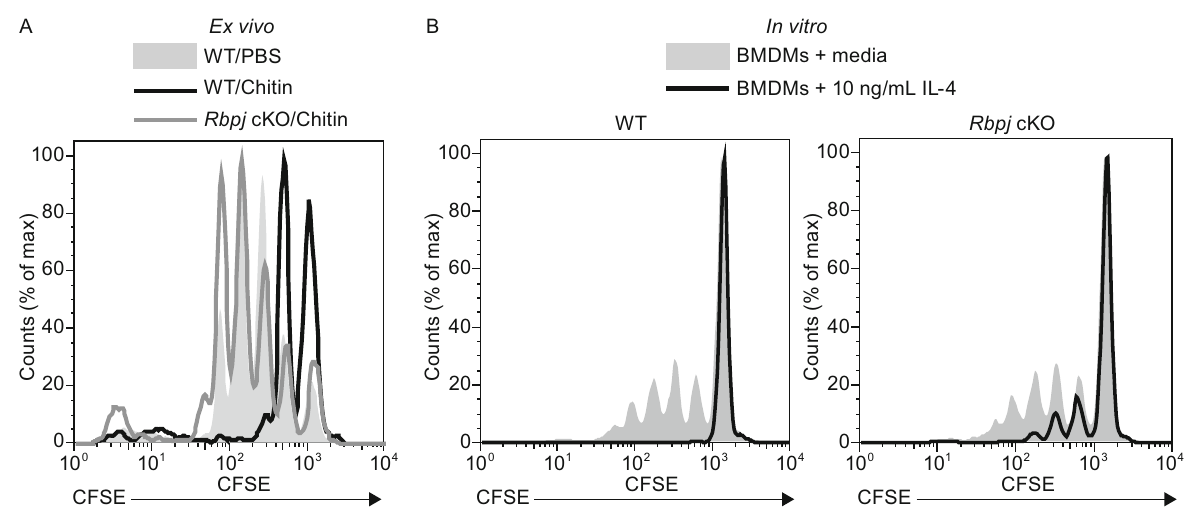
Figure 3. Rbpj -de fi cient alternatively activated macrophages are defective in suppressing T cell proliferation. (A) PECs from control, PBS-injected WT mice ( fi lled gray histogram), and day-1 chitin-elicited PECs from WT mice (black line) and Rbpj cKO (grey line) were co-cultured with CFSE-labeled LN cells from OT-II transgenic mice and cognate OVA peptide. Proliferation of CD4 + cells was examined at 96 h of co-culture. Results are representative of three independent experiments. (B) CFSE-labeled OT-II transgenic LN cells were co-cultured with control ( fi lled gray histogram) or IL-4-treated (10 ng/mL, black line) BMDMs from WTor Rbpj cKO mice and cognate OVA peptide. Proliferation of CD4 + cells was examined at 96 h of co-culture. Results are representative of two independent experiments.